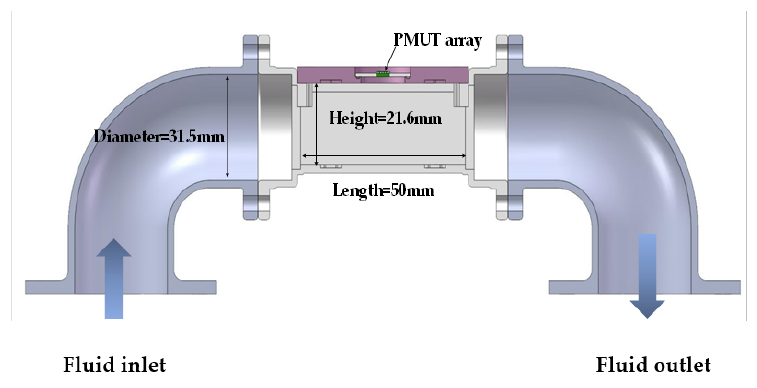
Figure 7. Scheme of the flow channel, the overall dimensions are 50 mm × 8.9 mm × 21.6 mm.